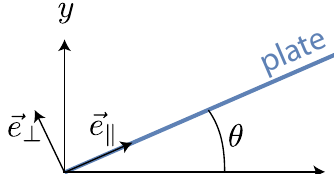
Figure A1. Coordinate system used by Sedov. The plate is moving through the water to the left at a speed u . The y direction represents the lateral direction in the water channel reference frame, and the x direction represents the streamwise direction in the water channel reference frame. A negative streamwise force F x would represent thrust. The directions (cid:126) e (cid:107) and (cid:126) e ⊥ are fixed to the plate and represent the tangential and normal directions,